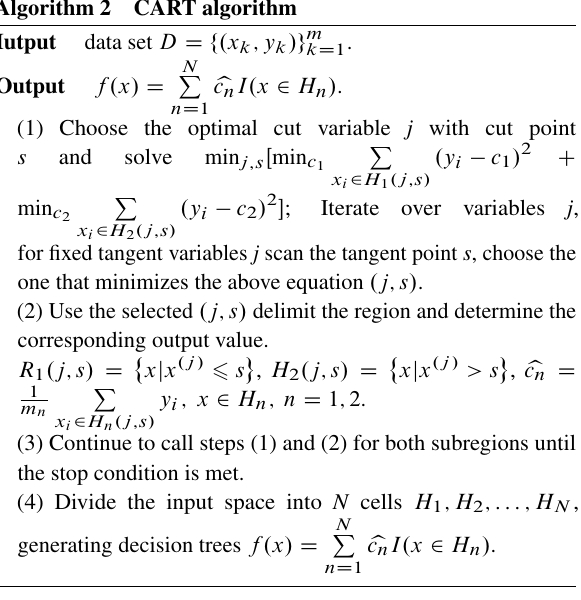
Algorithm 2 CART